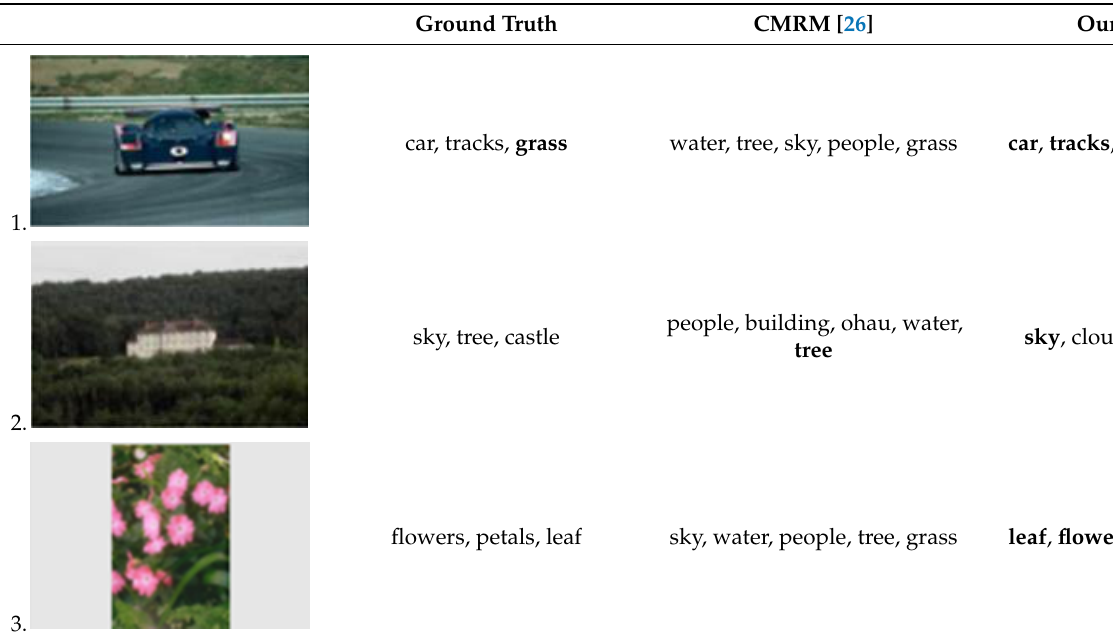
Table 3. A list of images with their respective ground truths and given annotations. Concepts in bold indicate that they are parts of the ground truth.